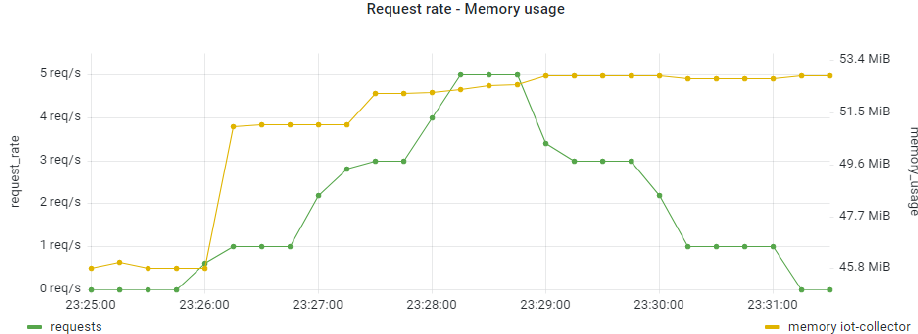
Figure 15. Memory usage for the IoT Collector component under the smooth workload.